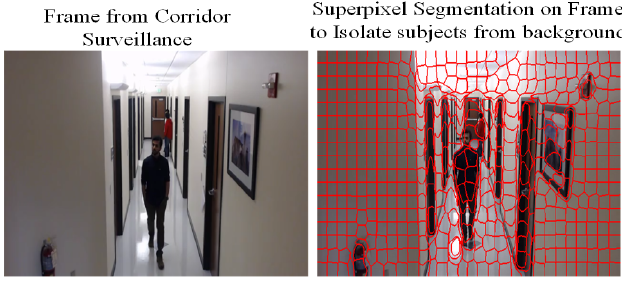
Figure 2. Superpixel segmentation on a surveillance